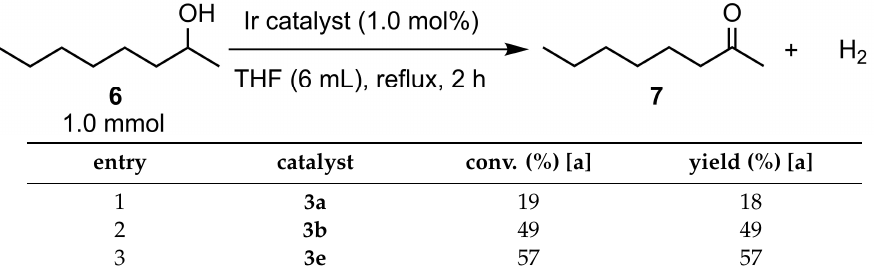
Table 2. Catalytic activity of iridium complexes ( 3 ) in the dehydrogenation of 6 .